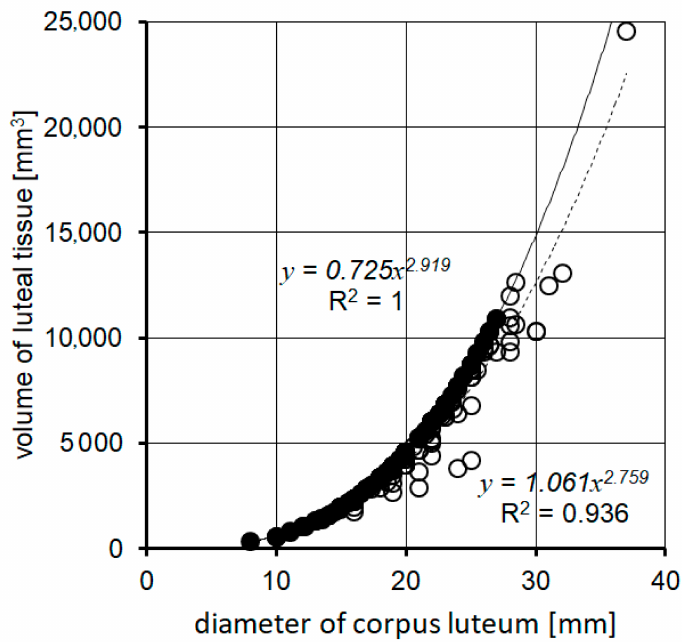
Figure 2. A comparison of volume of luteal tissue in CLs with and without a central cavity. • volume of luteal tissue in the compact CLs; volume of luteal tissue in the cavitary CLs. CL: corpus luteum. (cid:35)